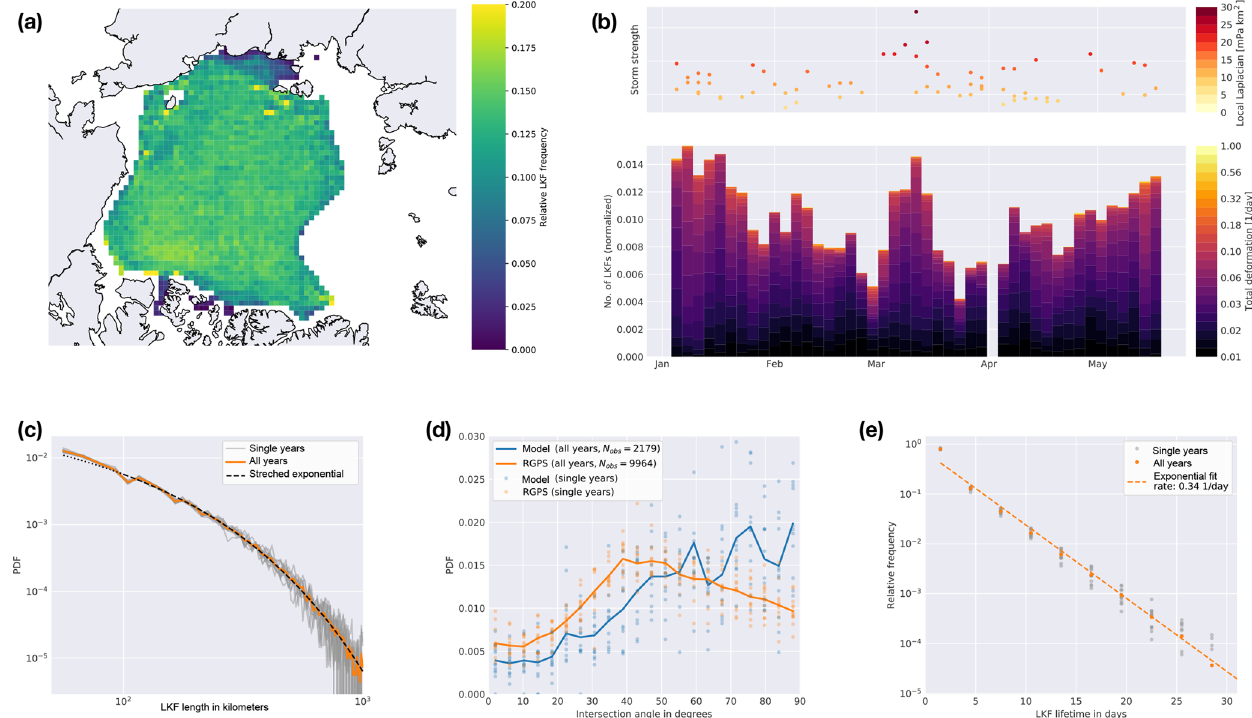
Figure 11. Statistics on LKF data set: (a) LKF density computed for the all years of the data set. (b) Time series of the number of LKFs separated by their deformation rates for winter 2002/03. The number of LKFs is normalized by the number of available pixels for each RGPS time record. For early April no RGPS data are available. For each time record all cyclones (Serreze, 2009) over the Arctic ocean are each shown as a dot in the upper panel. The y axis and the color code of the dots in the upper panel provide the local Laplacian of each cyclone as a proxy for its strength. (c) PDF of LKF length along with stretched-exponential fit for LKFs larger than 100km and smaller than 1000km. (d) Intersection angle of pairs of features that are newly formed (lifetime between 0 and 3 days) and have a size of at least 10 pixels for the RGPS and a 2km Arctic numerical model simulation. (e) Distribution of LKF lifetimes for all years along with a fit to an exponential